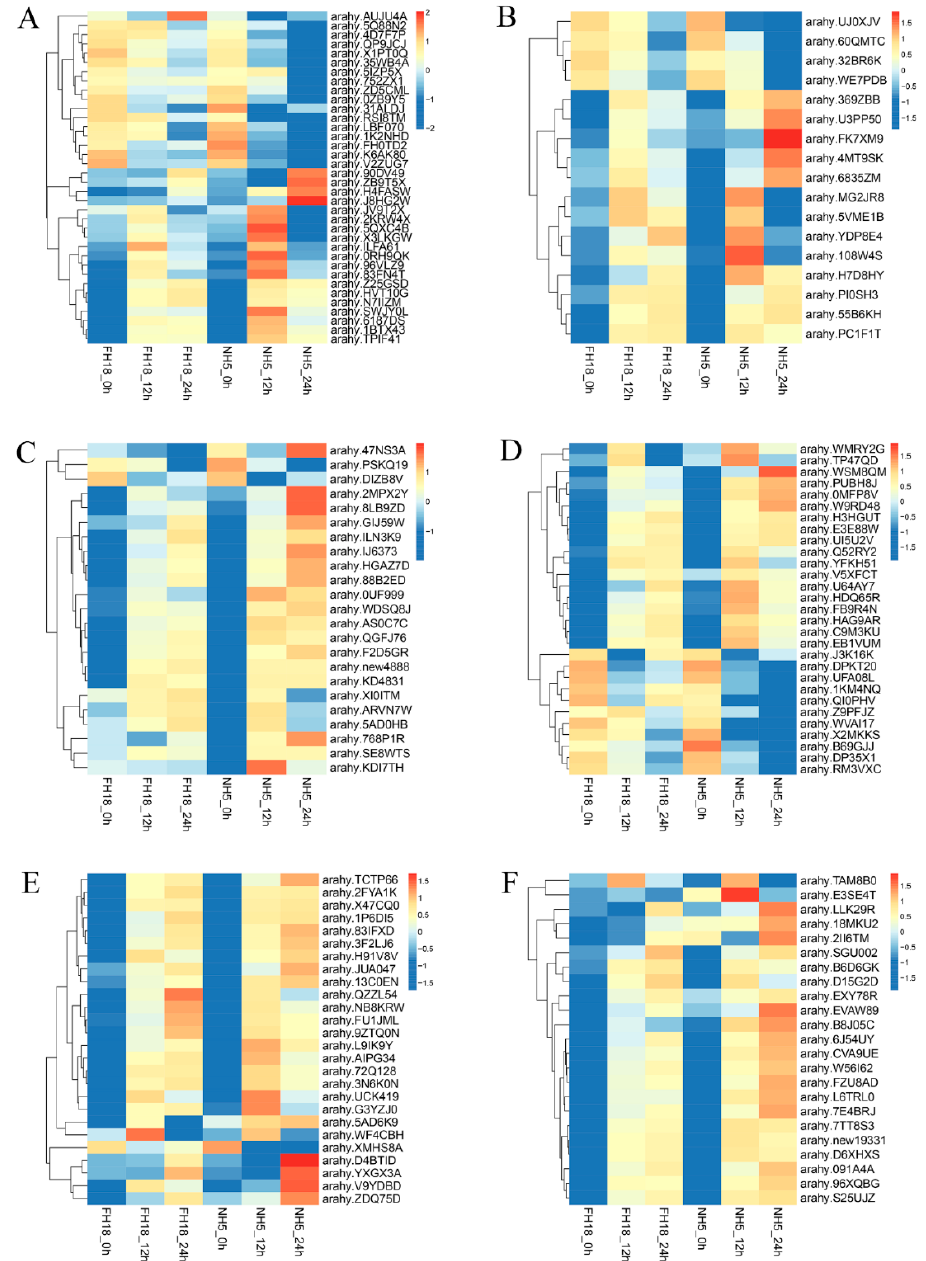
Figure 5. Heat map representing temporal expression profiles of peanut transcription factors under cold stress. The samples were collected at 0, 12, and 24 h cold stress. ( A ) bHLH (basic helix—loop—helix protein), ( B ) C2H2 ( Cys2/His2 zinc finger protein), ( C ) ERF (ethylene-responsive factor), ( D ) MYB (v-myb avian myeloblastosis viral oncogene homolog), ( E ) NAC (NAM, ATAF1/2, CUC2), and ( F ) WRKY.